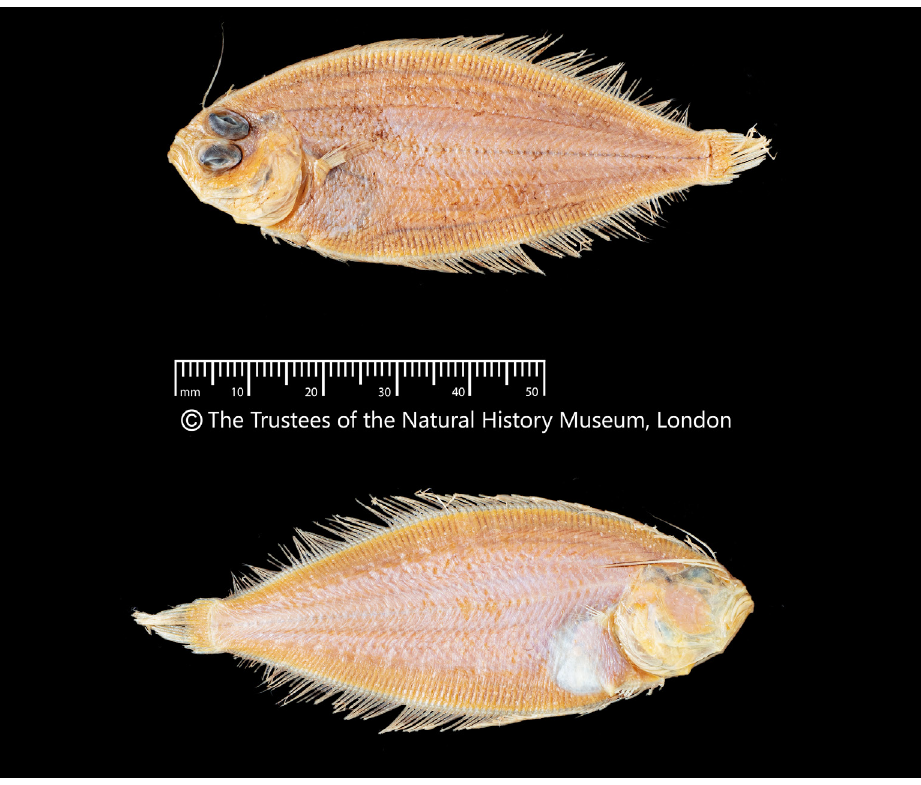
Fig. 1. – Arnoglossus blachei Stauch, 1965, BMNH 1930.5.6.36, one male, 73.7 mm SL, lectotype of A. blachei , 96.6 mm SL, Gabon, 27.2 km west of Cap Lopez. Photographs of preserved specimen taken by L. Goodayle. Above: Ocular side. Below: blind side. Scale indicated 5 cm.